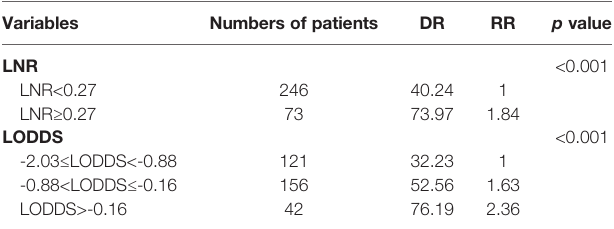
TABLE 2 | The optimal cut-off value of LNR and